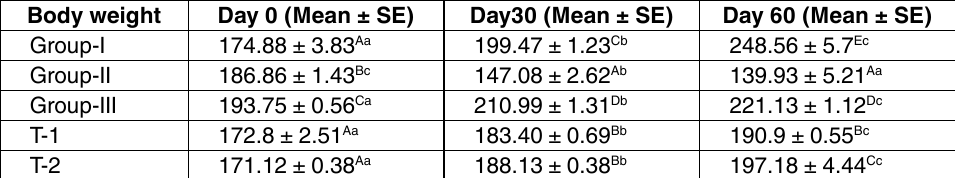
table1. Body weight (g) of experimental animals of different groups.